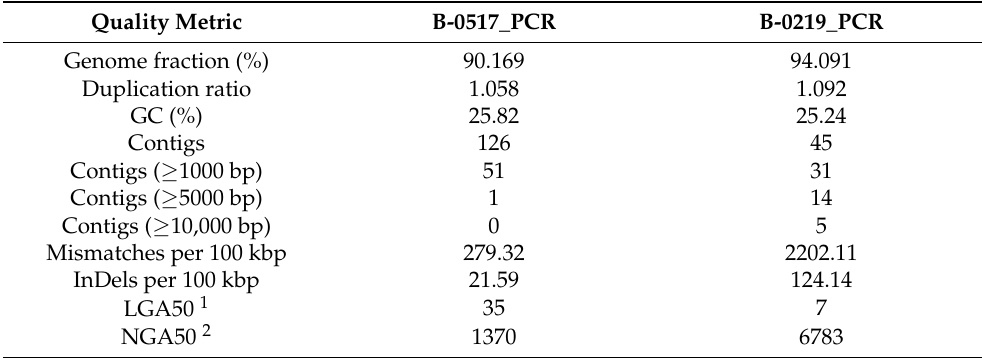
Table 2. Quality metrics of the de novo assemblies of the B-0517_PCR and B-0219_PCR datasets. Both datasets were assembled using a standard de novo strategy, and the assemblies were evaluated with QUAST using a typical Neethling-based vaccine strain (i.e., LSDV-Herbivac) as a reference genome.